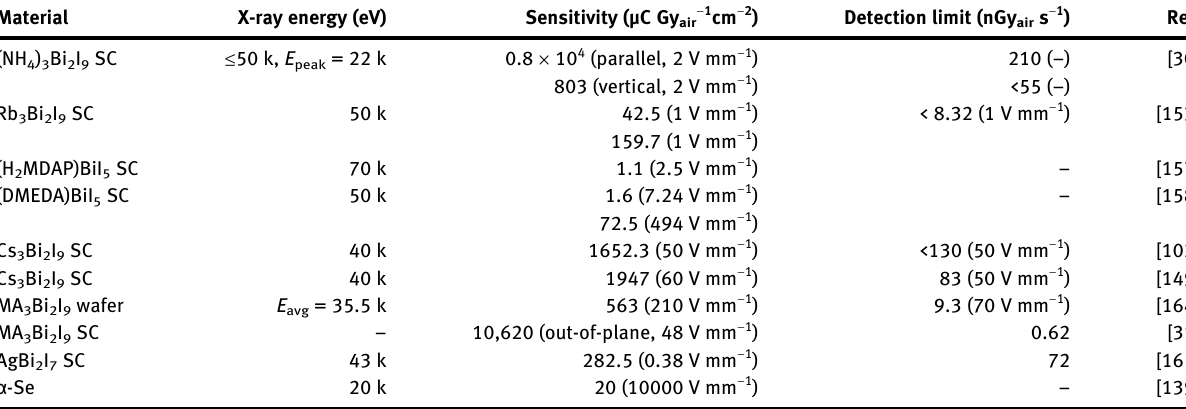
Table  : Summary of the X-ray detector parameters of Bi-based perovskite variants.